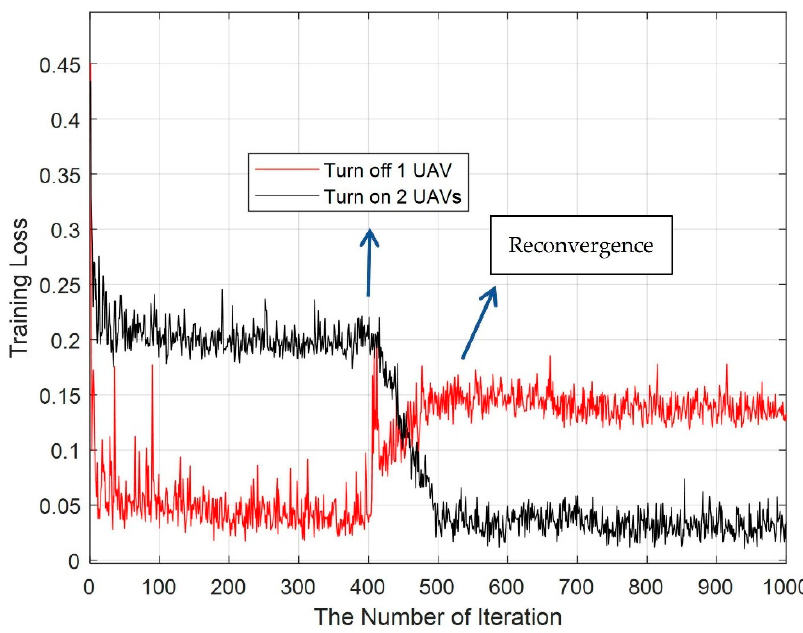
Figure 8. Training loss obtained by turning UAV on or off in the MEC system at iteration